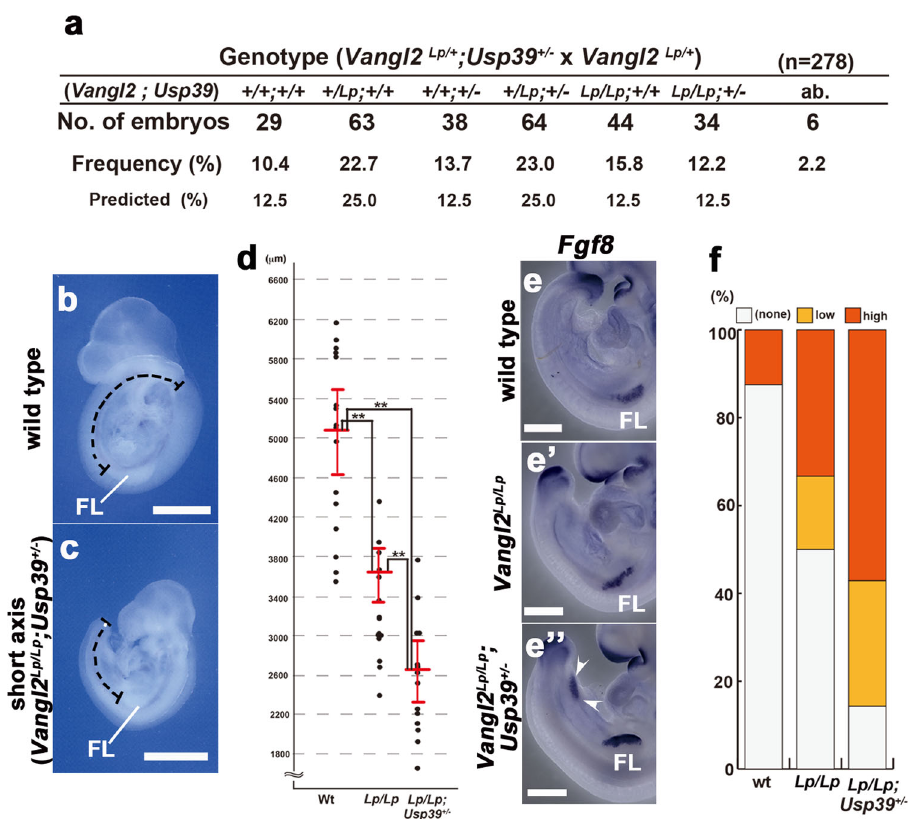
Fig. 6 Axial elongation of Vangl2 Lp/Lp embryos is shortened by removal of one copy of the Usp39 gene. a Frequencies of genotypes among embryos from crossing Vangl2 Lp/ + ; Usp39 + / − with Vangl2 Lp/ + mutant mice at E9.5. b , c Morphological features of wild-type ( b ) and Vangl2 Lp/Lp ; Usp39 + / − ( c ) embryos at E9.5. d Measured longitudinal lengths, from the ventral forelimb to caudal tip of the tail bud, in wild-type, Vangl2 Lp/Lp , and Vangl2 Lp/Lp ; Usp39 + / − embryos at E9.25 ( b , c ; dashed lines, d ). e – e ″ In situ hybridization for Fgf8 expression in wild-type ( e ), Vangl2 Lp/Lp ( e ′ ), and Vangl2 Lp/Lp ; Usp39 + / − ( e ″ ) embryos. Fgf8 expression in the presumptive hindlimb region is ectopically observed in Vangl2 Lp/Lp ; Usp39 + / − embryos ( e ″ , white arrowheads). f Quanti fi cation of ectopic Fgf8 expression in the presumptive hindlimb region of wild-type, Vangl2 Lp/Lp , and Vangl2 Lp/Lp ; Usp39 + / − embryos at E9.25. FL forelimb. Scale bars represent 100 μ m ( b , c ) and 50 μ m ( e – e ″